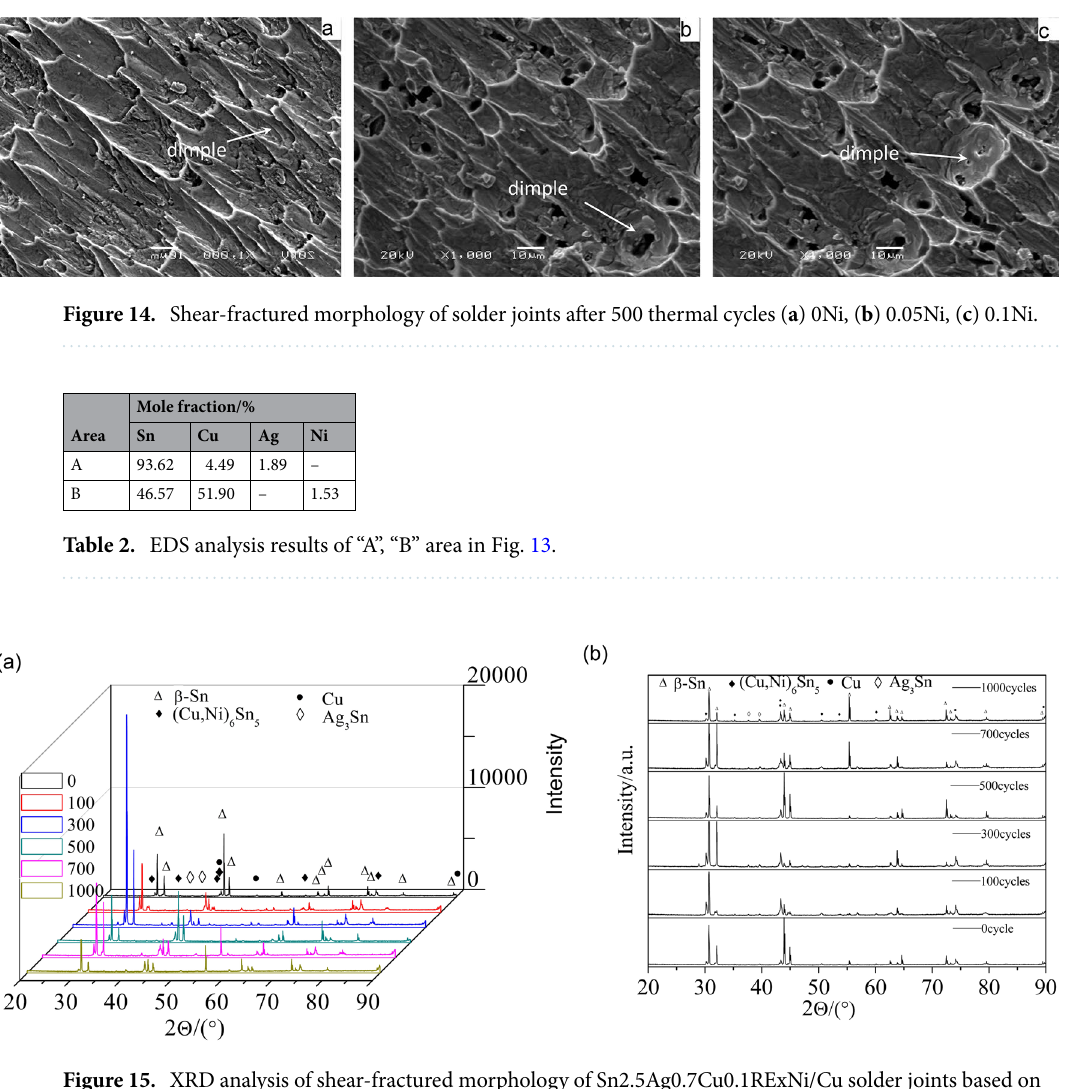
Figure 15. XRD analysis of shear-fractured morphology of Sn2.5Ag0.7Cu0.1RExNi/Cu solder joints based on ( a ) actual intensity, ( b ) intensity in